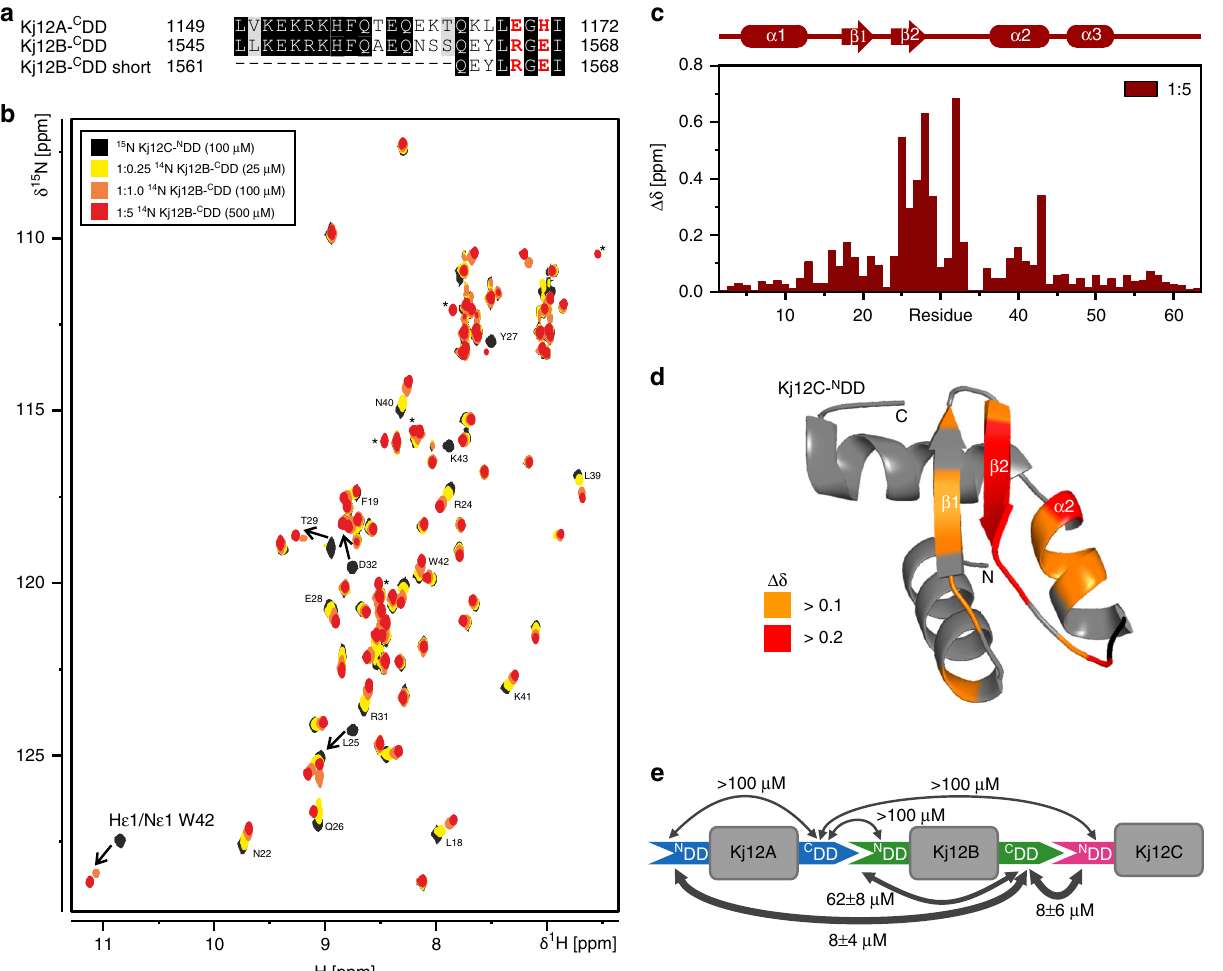
Fig. 3 Docking domain interaction. a Sequence alignment of Kj12A- C DD and Kj12B- C DD used in this study. Identical residues are highlighted with dark gray boxes and residues with similar chemical properties are shown in light gray boxes. Key residues for DD interactions are shown in red. b Overlay of the 1 H, 15 N-HSQC spectrum of 100 µ M 15 N-labeled Kj12C- N DD in the absence (black) and presence of increasing amounts of unlabeled Kj12B- C DD. The molar ratios of the two docking domains are 1:0.25 (yellow), 1:1 (orange), 1:2.5 (dark orange), and 1:5 (red). c Histogram of chemical shift changes vs. sequence for Kj12C- N DD upon addition of a fi ve-fold molar excess of unlabelled Kj12B- C DD with the secondary structure depicted above. d Chemical shift changes for Kj12C- N DD upon addition of unlabeled Kj12B- C DD mapped onto the structure of Kj12C- N DD. e K d values for all DD interactions in the Kj12ABC NRPS as measured by the mean structures for all three Kj12- N DDs are shown in Sup- plementary Fig. 4. In all three N DDs, β 1 and β 2 form an anti- parallel β -hairpin. Helices α 1 and α 2 are packed against each